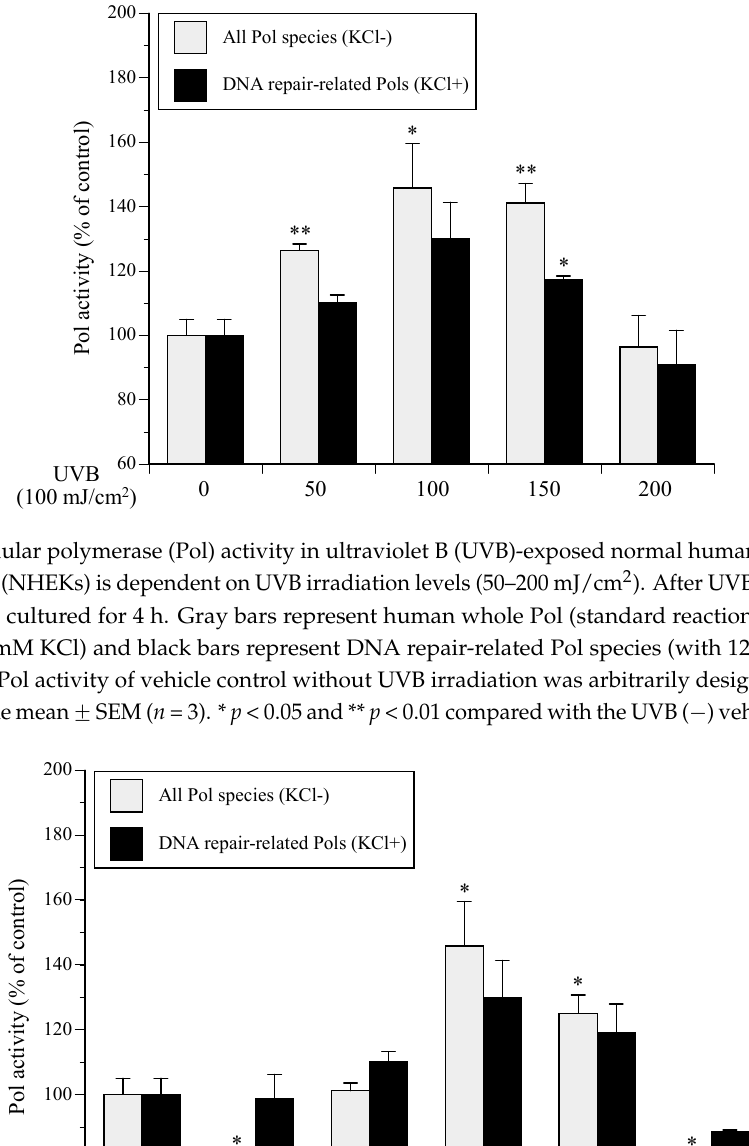
Figure 2. Pol activity depends on incubation time (1–24 h) in 100 mJ/cm 2 UVB ‐ exposed NHEKs. Gray bars represent human whole Pol (standard reaction conditions without 120 mM KCl) and black bars represent DNA repair ‐ related Pol species (with 120 mM KCl), respectively. Pol activity of vehicle control without UVB irradiation was arbitrarily designated 100%. All data are the mean ± SEM ( n = 3). * p < 0.05 with the UVB ( − ) vehicle control.